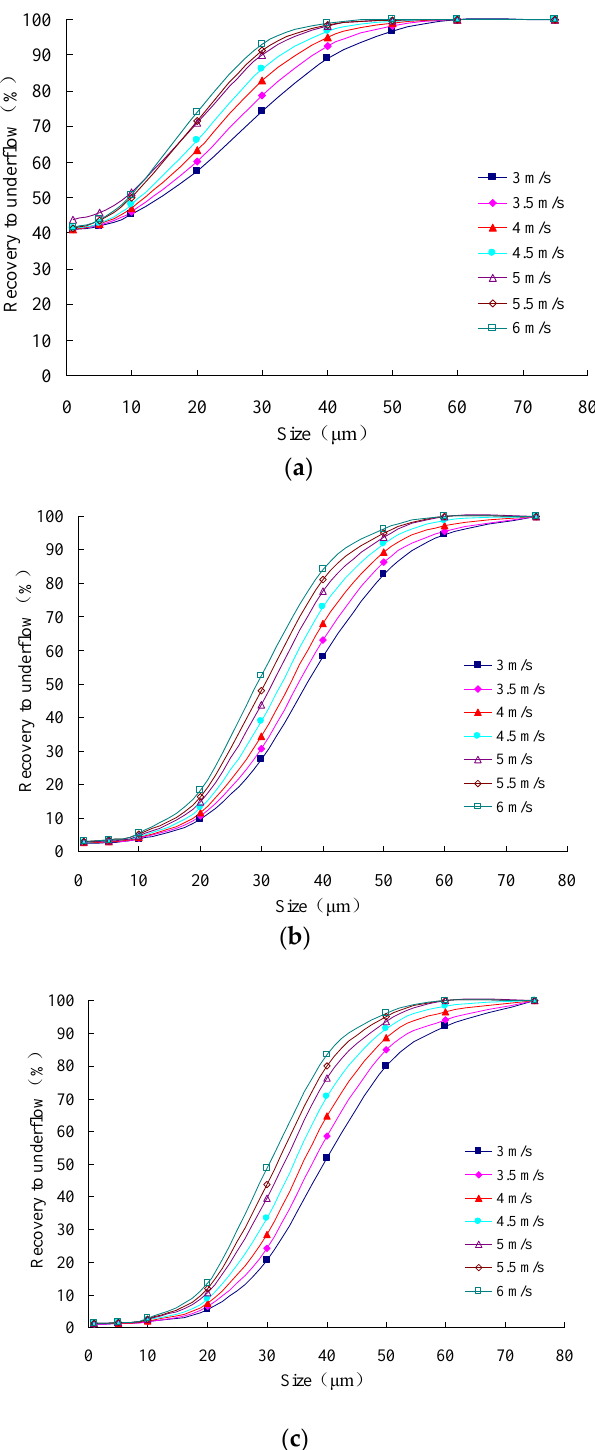
Figure 10. Separation efficiency: ( a ) first stage; ( b ) second stage; ( c ) TS hydrocyclone.